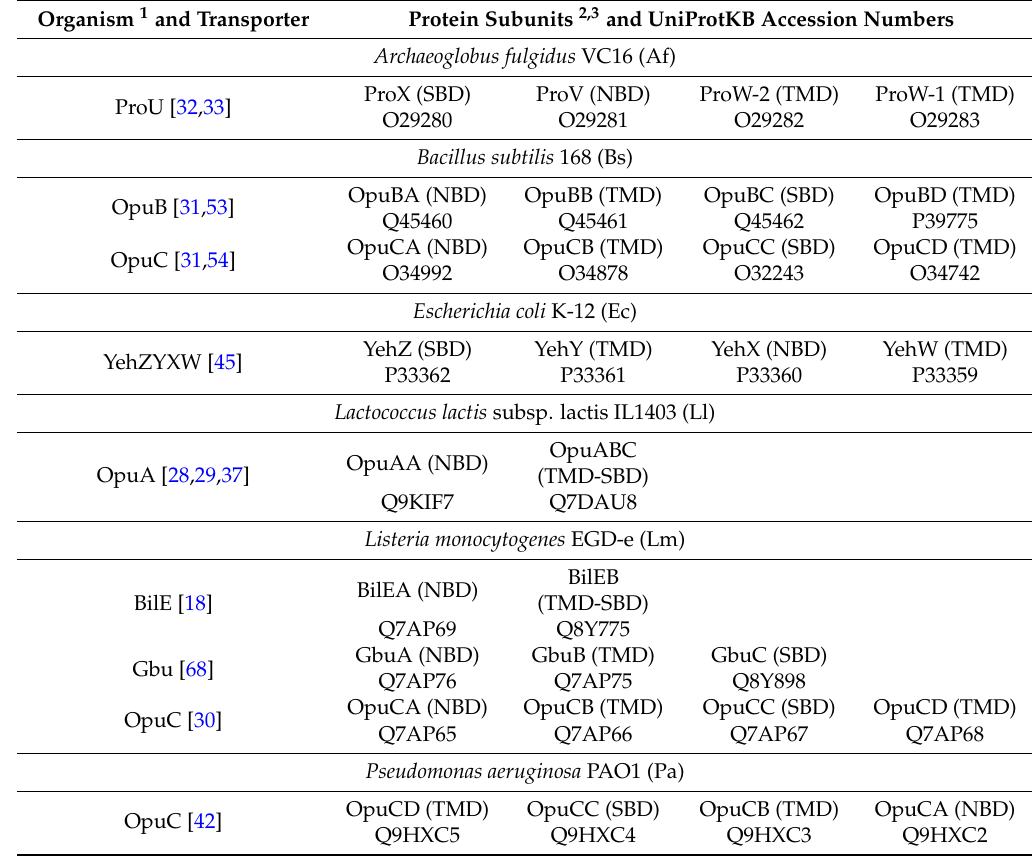
Table A1. Proteins used in this study for sequence- and structure-based